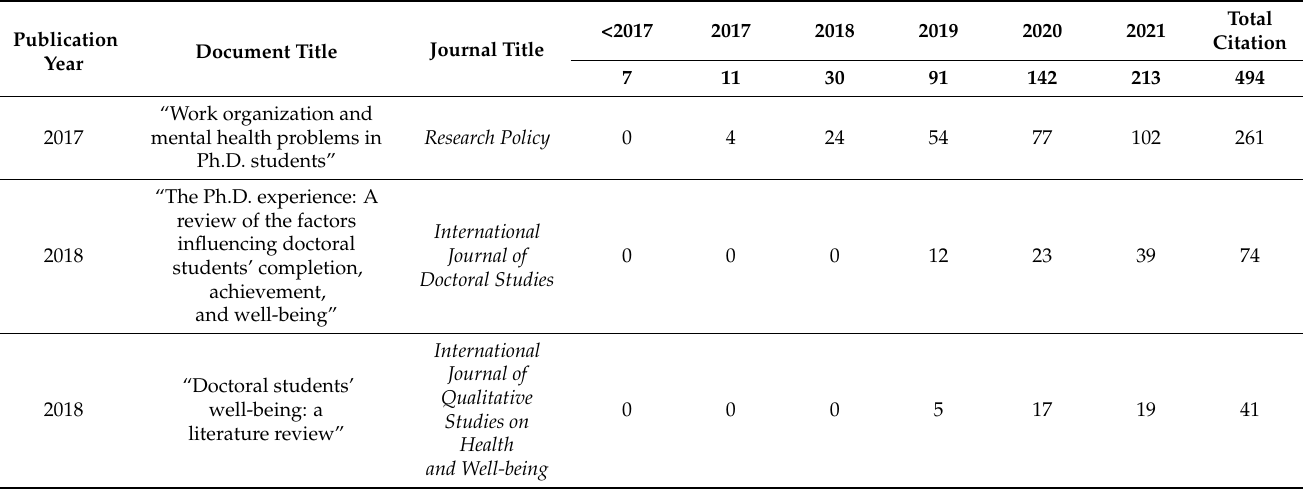
Table 1. Top 10 publications with most citation on the subject of mental health and well-being among graduate